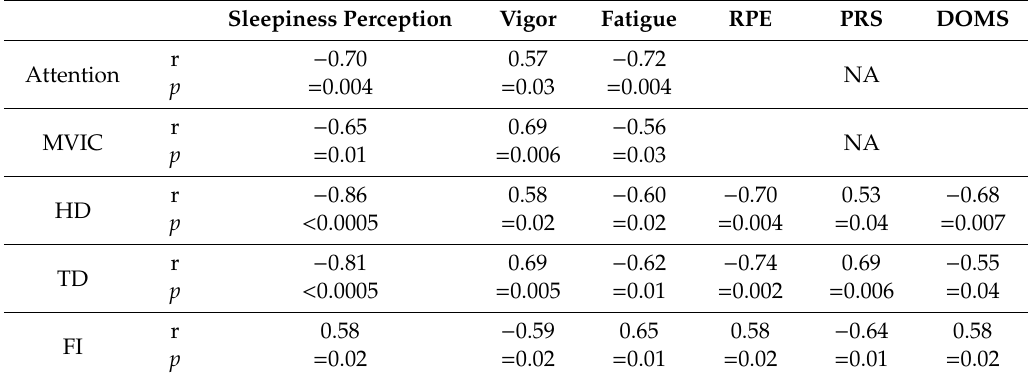
Table 6. Correlations between selected parameters for changes between N90 and N0. Sleepiness